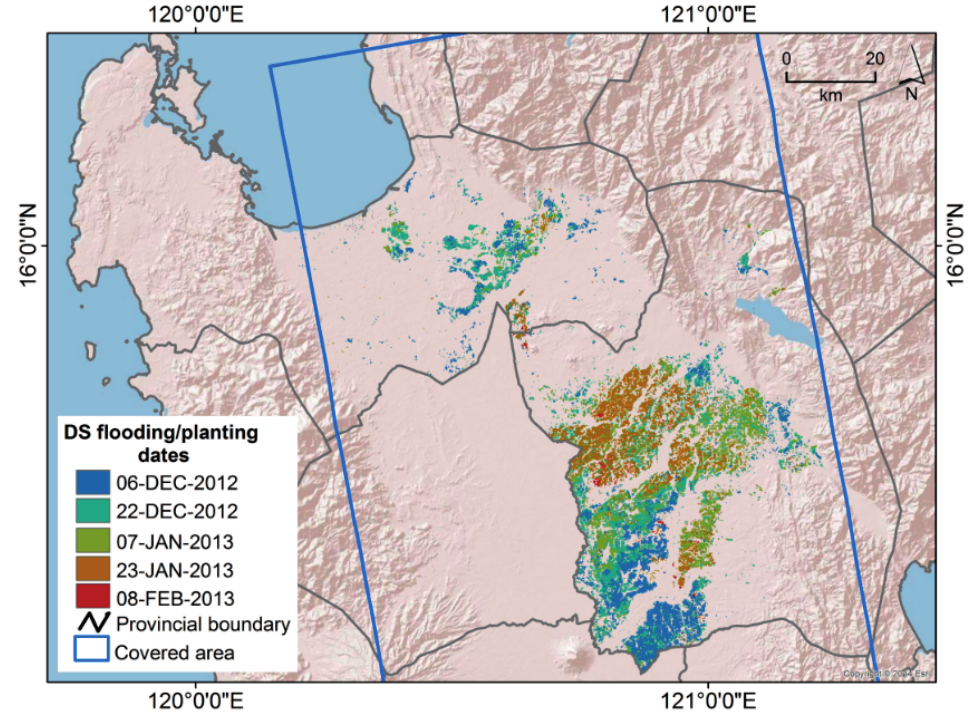
Figure 7. Flooding/transplanting dates within the rice areas during DS 2012–2013 generated from CSK ScanSAR multitemporal images.